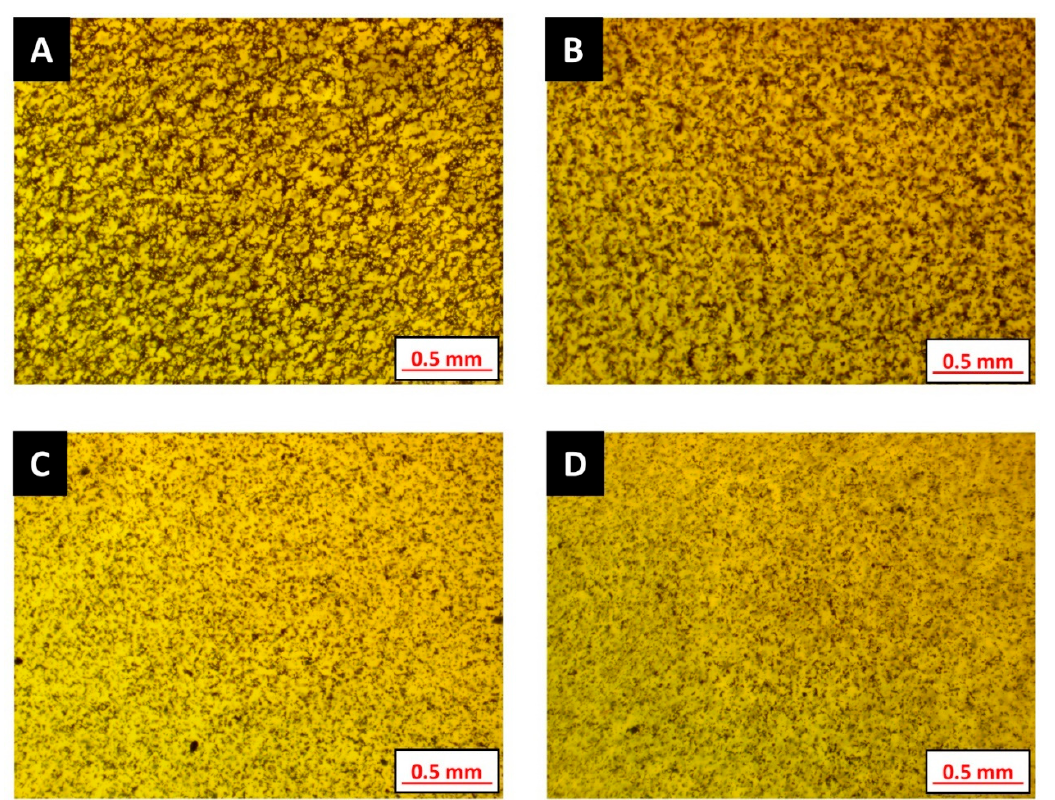
Figure 6. Particle aggregation decreasing from ( A )–( D ) in photosensitive polymer formulations, as listed in Table 5, ( A ), ( B ), ( C ) and ( D ) have different BYK 7410ET additive loading separately.